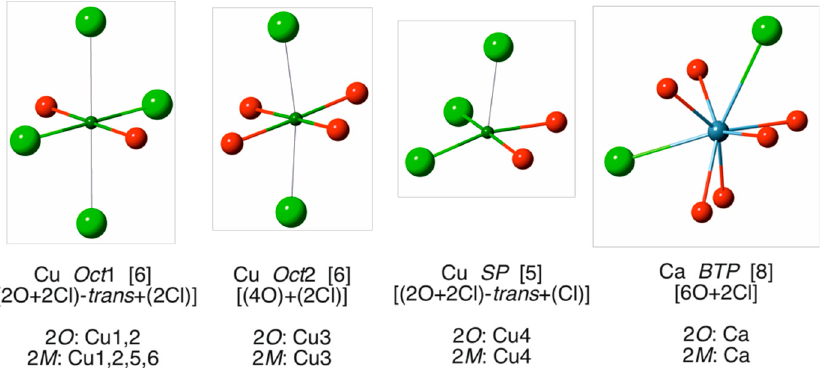
Figure 6. Four types of cation coordination in the crystal structures of dioskouriite-2 M and dioskouriite-2 O (see text for details). Legend as in Figure 5. Oct , BTP and SP mean octahedral, bicapped trigonal prismatic and (distorted) square pyramidal coordination of cation, respectively.